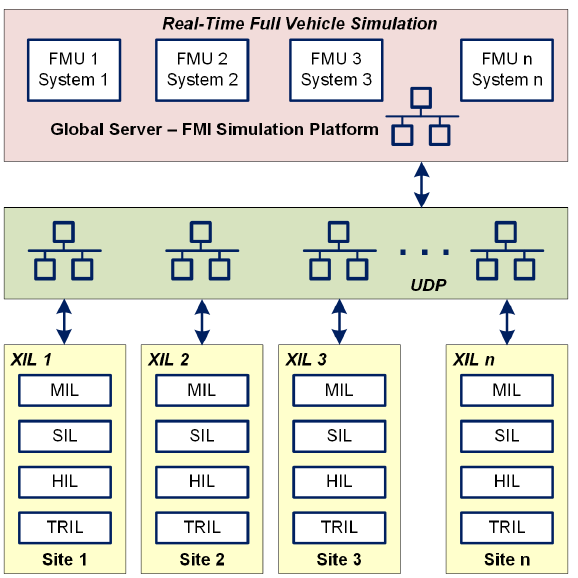
Figure 3. Distributed remote XILforEV architecture in multiple sites via the internet.